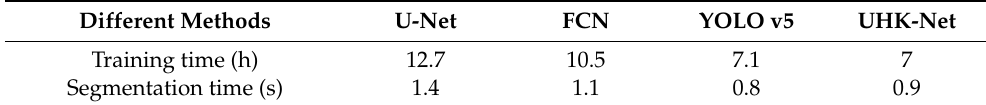
Table 3. Training and detection time of different methods. Different